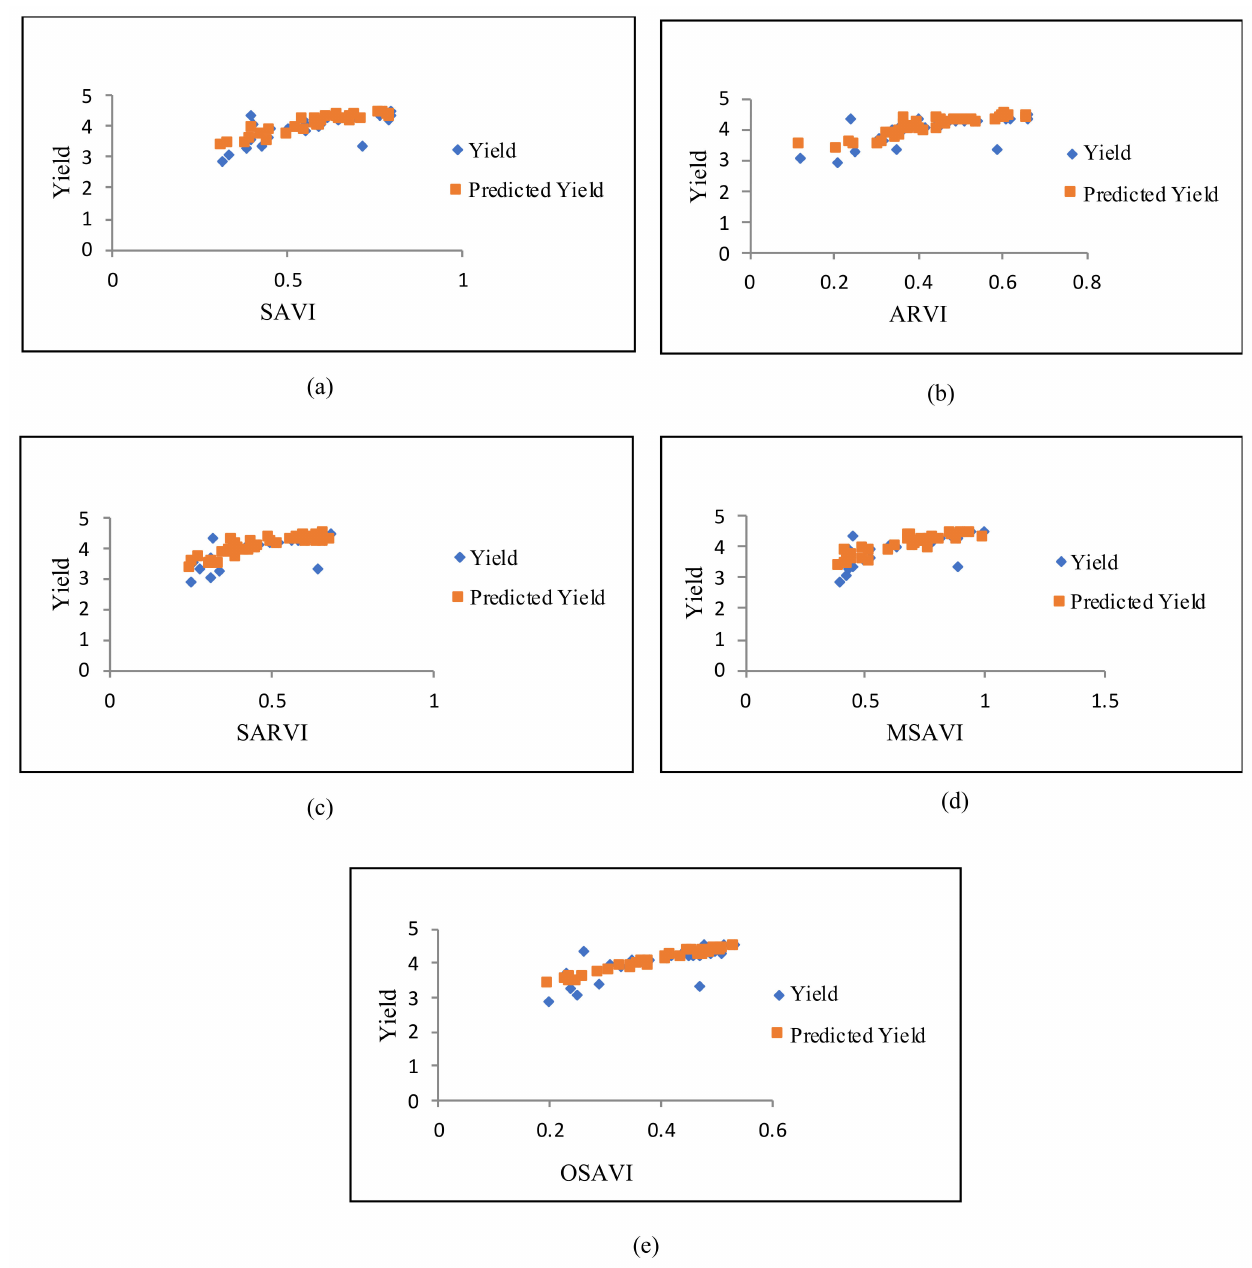
Figure 7. Comparison of actual yield and predicted yield for different indices ( a ) SAVI ( b )ARVI, ( c ) SARVI, ( d ) OSAVI, ( e )